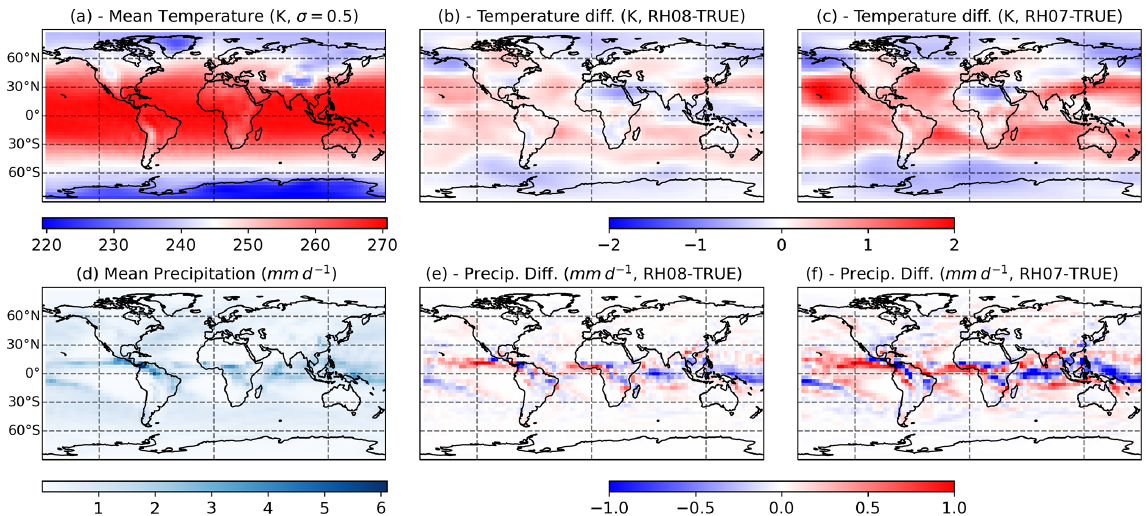
Figure 5. The 30-year mean for the TRUE model simulation (a, d) and differences between the TRUE model simulation and the RH08 and RH07 mode simulation ( b , e , c , f , respectively), for temperature at the vertical level σ = 0 . 5 ( a , b , c , K ) and total precipitation ( d , e , f , mmd − 1